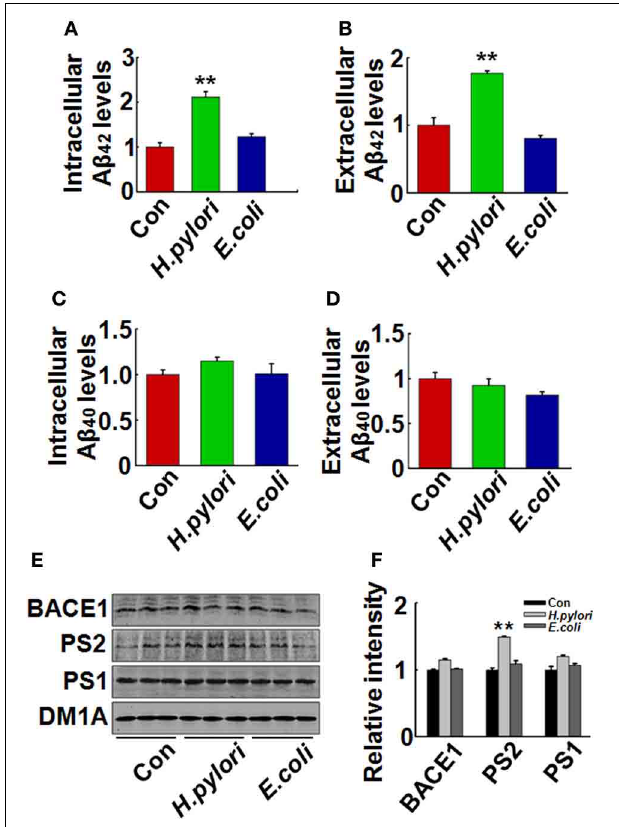
FIGURE 7 | H. pylori filtrate increases A β 42 production with enhanced expression of PS-2 in N2a/APP cells. N2a/APPs cells were incubated with H. pylori or E.coli filtrate for 24h. The levels of A β 42 and A β 40 in the medium and cell lysates were measured by ELISA (A–D) . H. pylori filtrate increased A β 42 both in the cell lysates (A) ( p = 0 . 001, F = 25 . 087) and the medium (B) ( p = 0 . 002, F = 29 . 247) in N2a/APP cells, with no effect on A β 40 levels (C,D) . The protein levels of PS-1, PS-2, and BACE-1 in the cell lysates were measured by Western blotting (E,F) . H. pylori filtrate incubation resulted in increased expression of PS-2 in cells. E , representative bands; F , quantitative analysis, p = 0 . 001, F = 22 . 92. All experiments were repeated at least three times. ∗∗ p < 0 . 01 vs. control group (mean ± SD, n = 9 for ELISA; n = 3 for Western